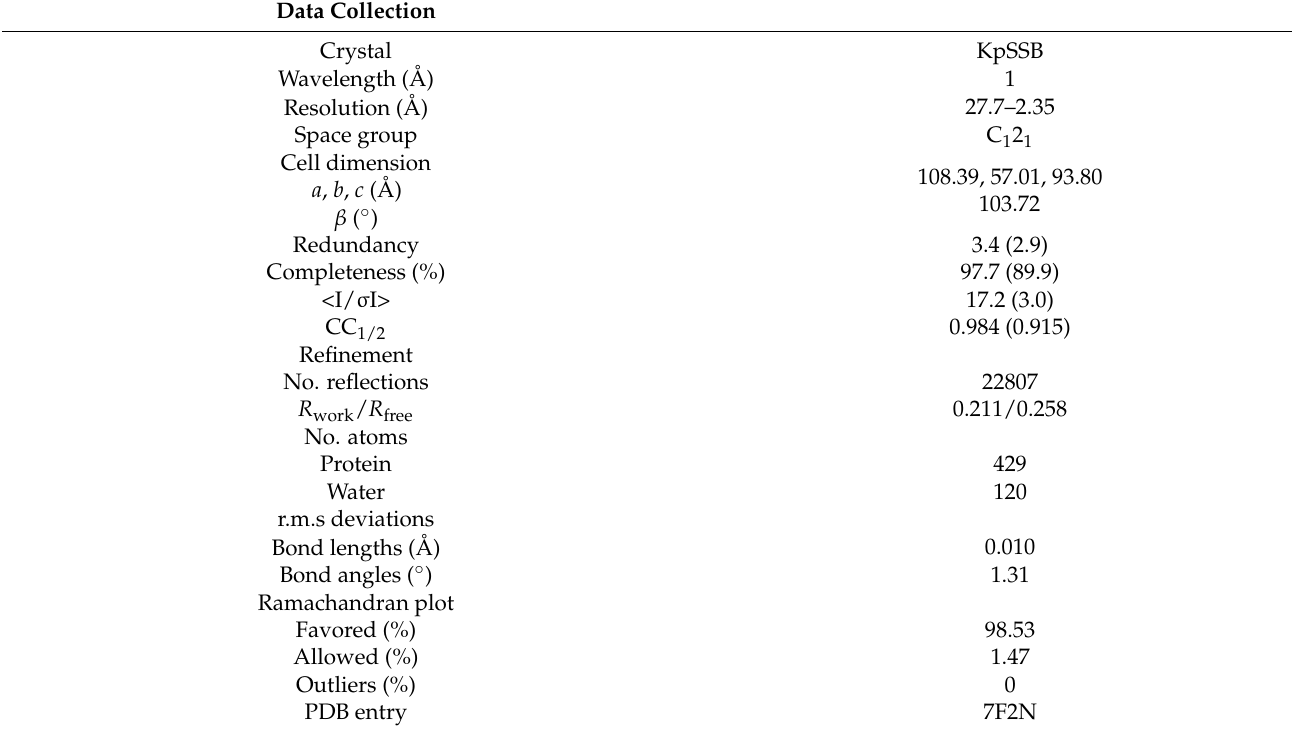
Table 1. Data collection and refinement